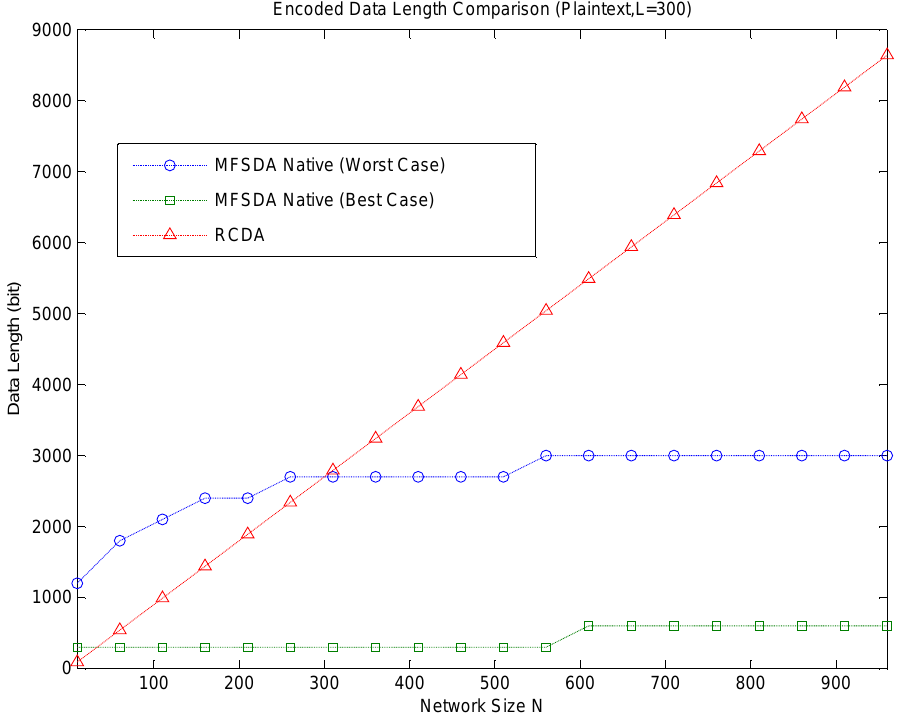
Figure 3. Communication cost comparison of RCDAand MFSDA.